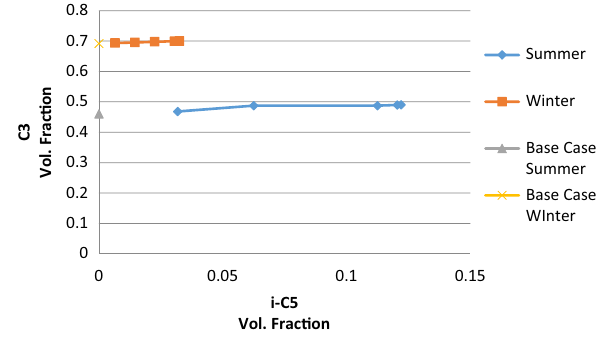
Fig. 9 Effect of adding i-C5 on LPG propane content